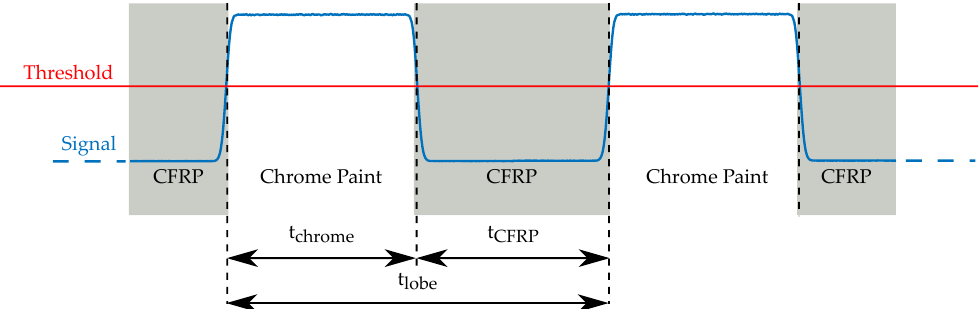
Figure 2. Electrical output signal from the OESM system. The transition from CFRP to chrome paint is called the edge transition function and is not an ideal step function. A threshold is applied to determine the time of the